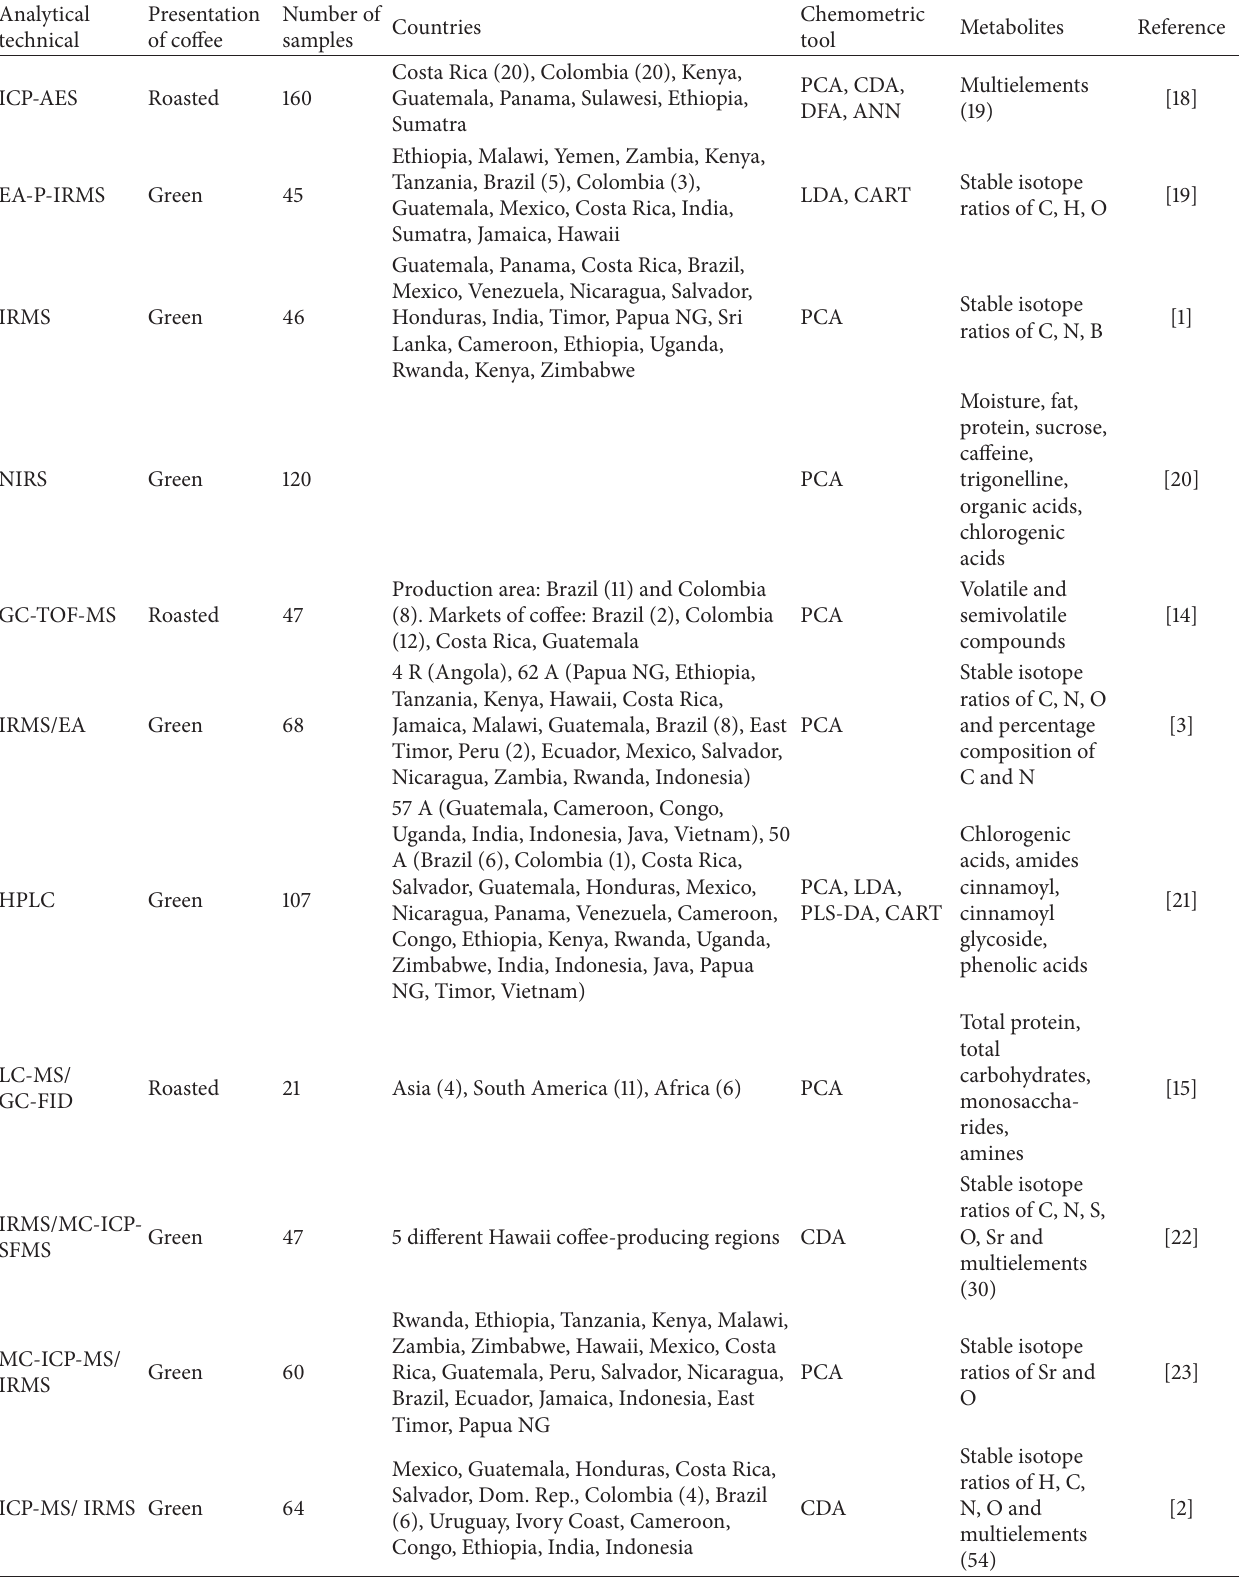
Table 1: Scientific articles on determination of origin of